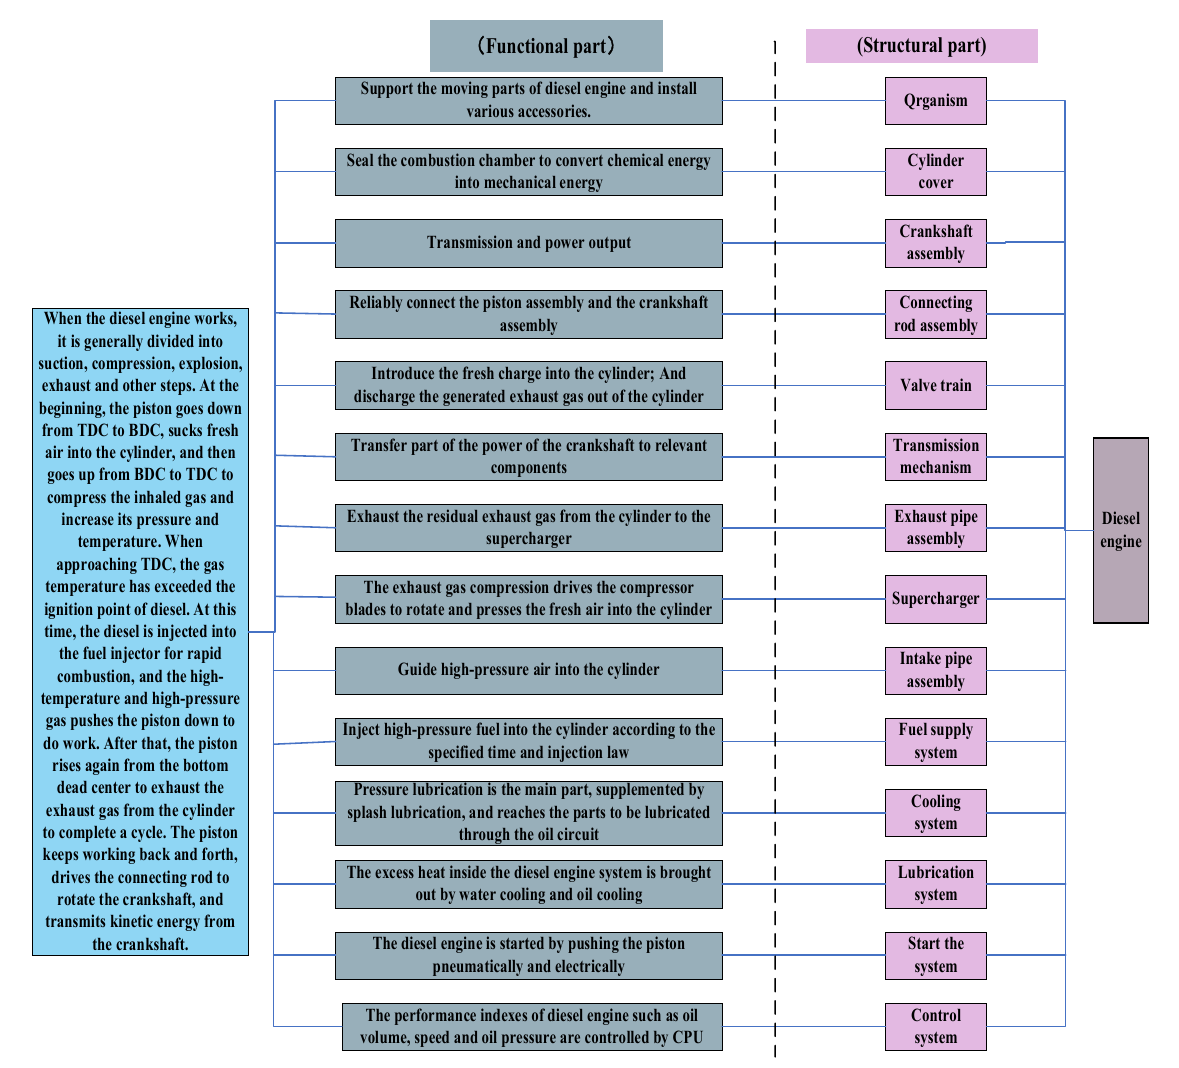
Figure 11. The corresponding relationships between the product function level and the structure level of diesel engines.